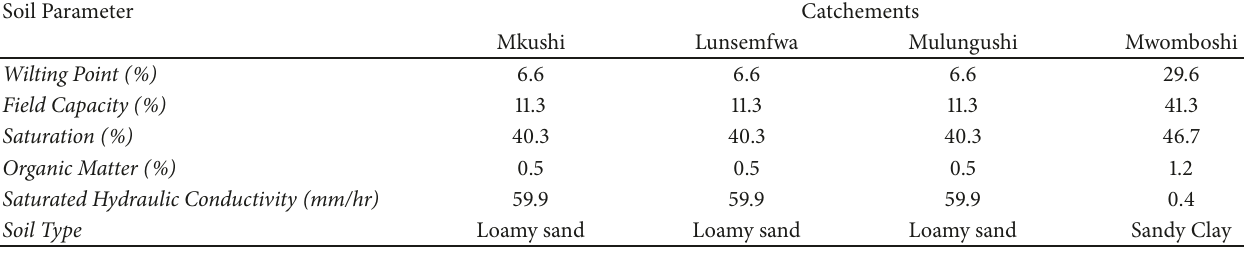
Table 4: Soil physical properties.